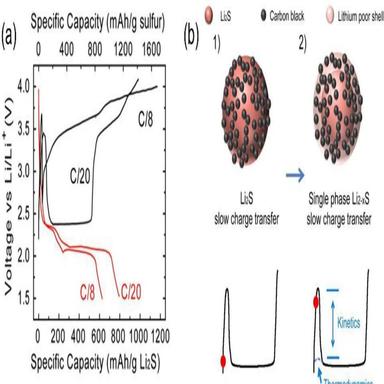
The electrochemical behaviors of commercial Li2S-MCs. (a) Voltage-capacity profiles at two cycling rates of C/8 and C/20. (b) The schematic showing the structural change and the activation harrier due to the difference between kinetics and thermodynamics. Reproduced from Ref. with permission from the American Chemical Society.